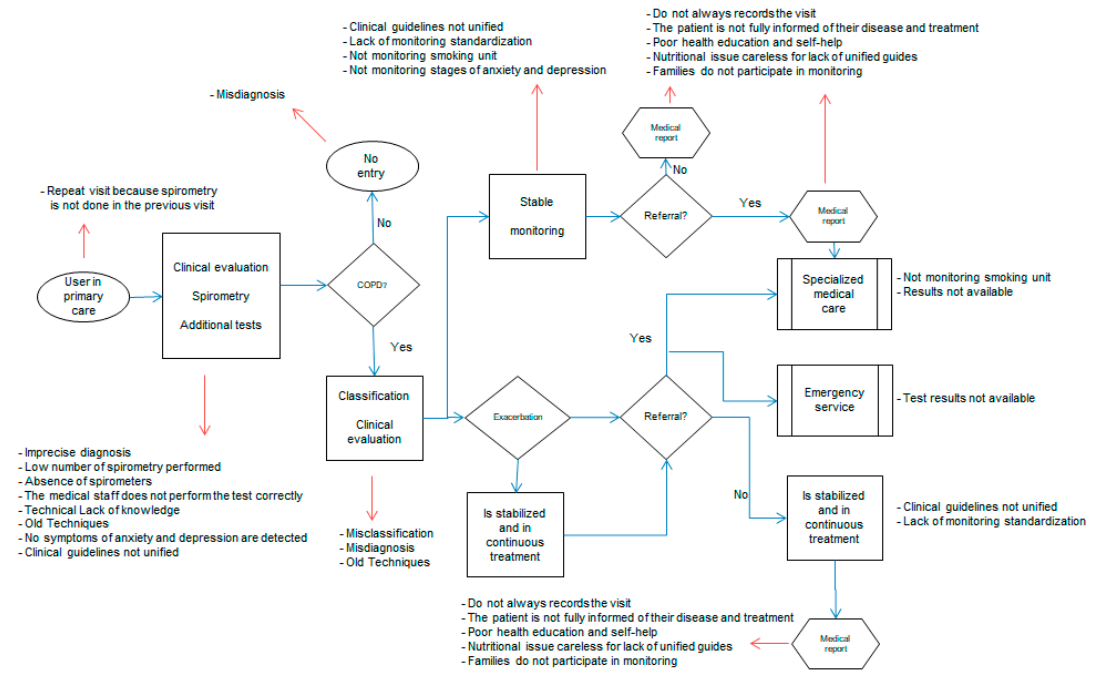
Figure 2. COPD clinical process with the detected